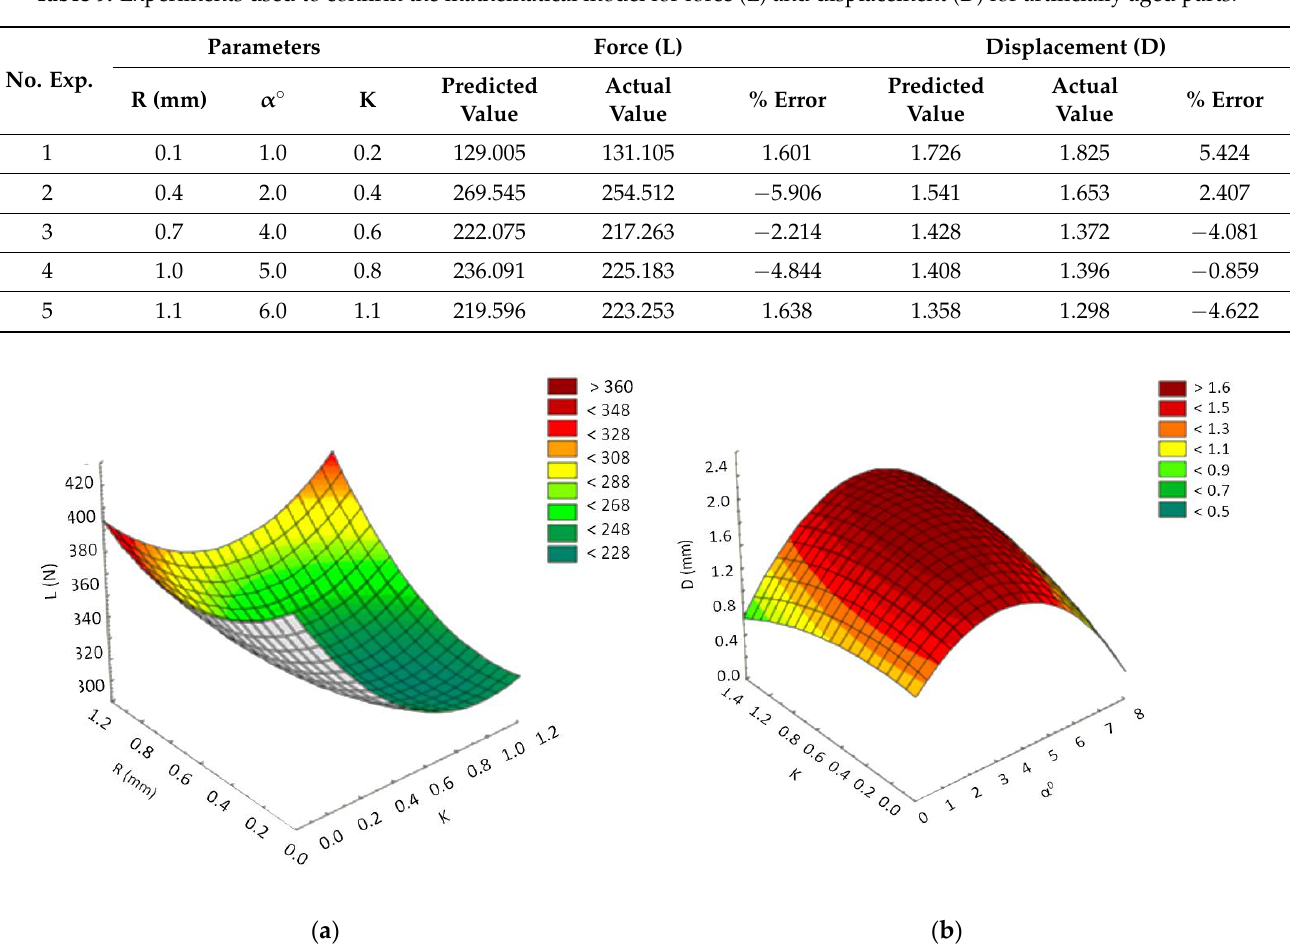
Figure 7. Graphs of the response surface for force (L) as a function of K and R ( a ), and for displacement (D) as a function of α and K ( b ).